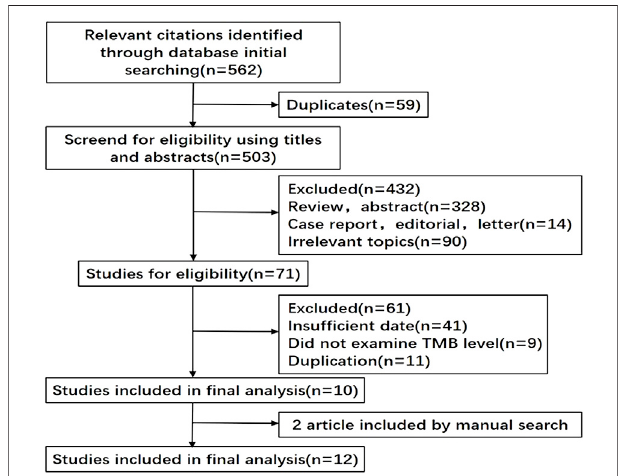
FIGURE 1 | Flowchart of literature search and